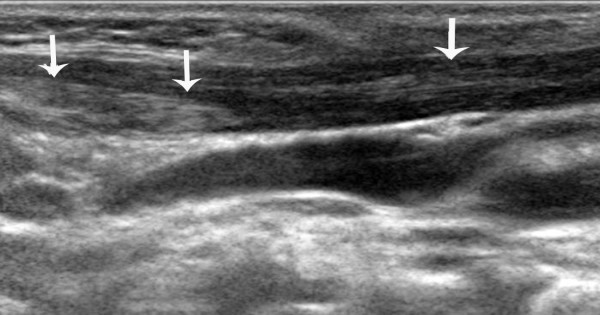
Vertical section of the sternocleidomastoid muscle (SCM) in a patient with late-stage muscular torticollis. Cord-like hyperechoic signals are apparent inside the affected SCM, with a clear boundary.